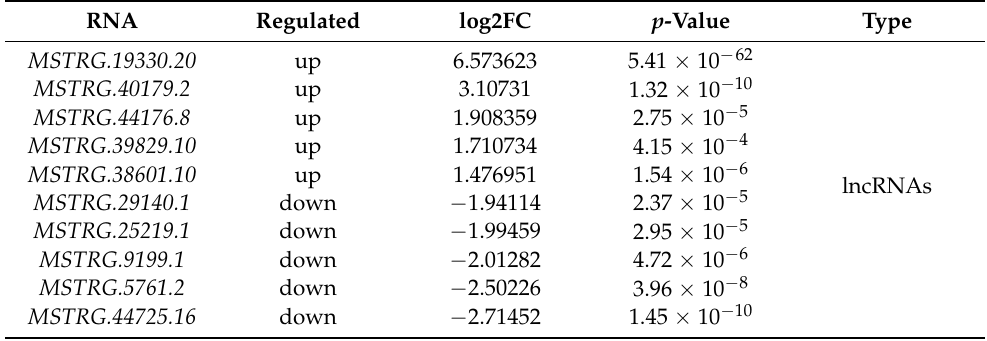
Figure 1. Statistics of differentially expressed RNAs in the high- and low- IMF groups. ( A ) The genome-wide distribution and expression schema for differentially expressed RNAs. ( B ) Number of differentially expressed RNAs in the two groups ( p -value < 0.01 (mRNA, lncRNA, and circRNA), and p -value < 0.05 (miRNA)). Table 2. Summary of top up-regulated and down regulated DE circRNAs, miRNAs, lncRNAs, and mRNAs between high- and low-IMF groups.